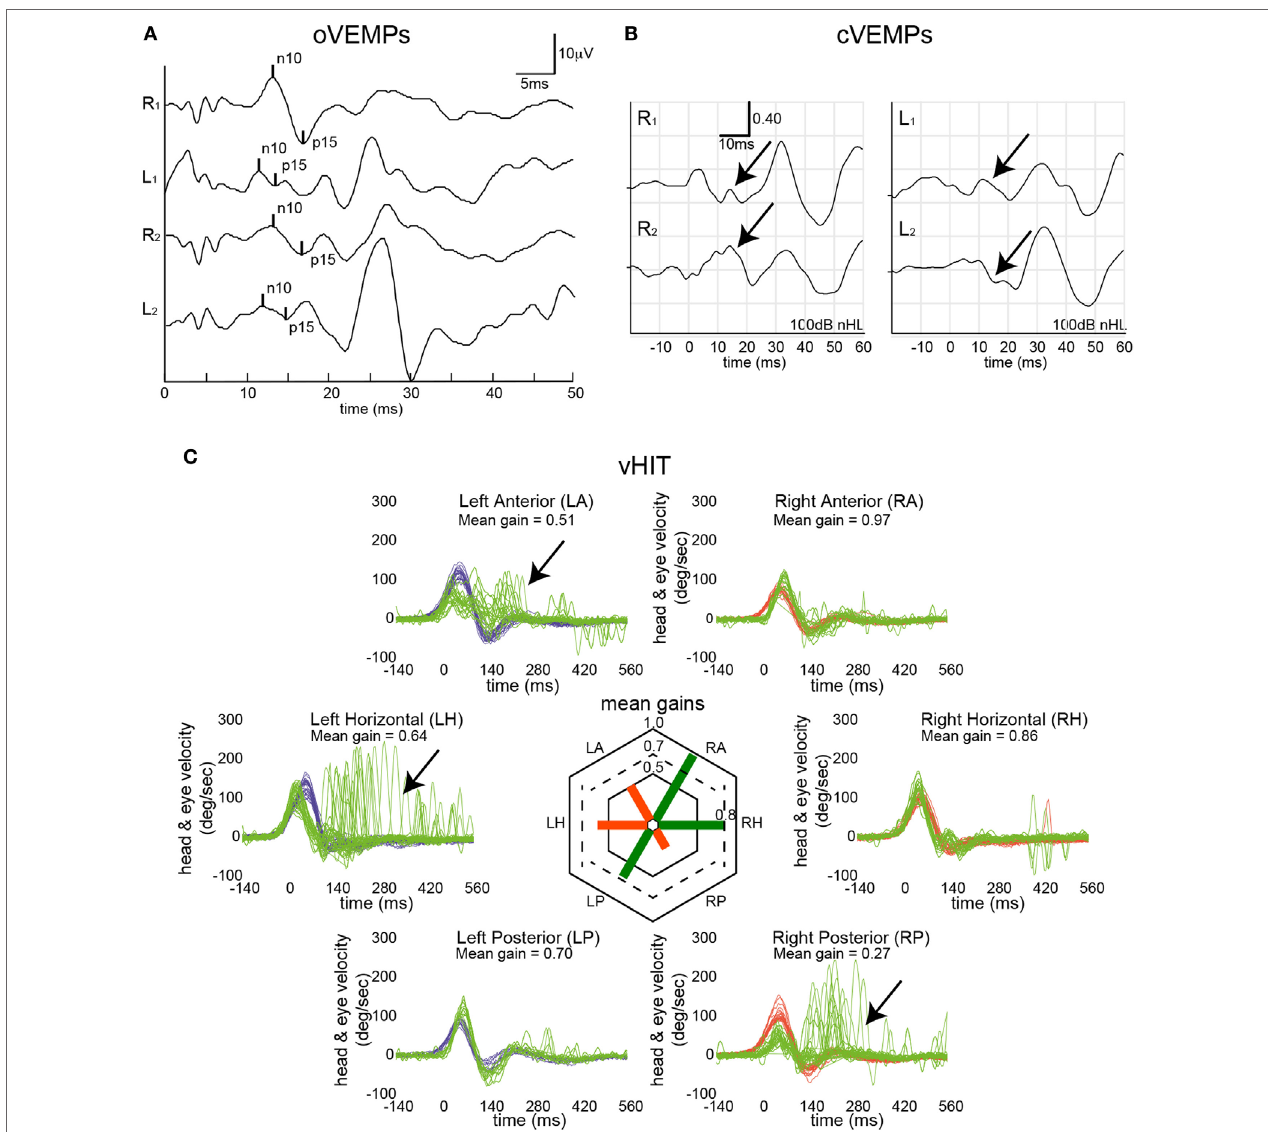
FigUre 1 | Vestibular mapping in a single patient with bilateral Menière’s disease. Otolith testing indicated left-sided utricular impairment [ocular vestibular-evoked myogenic potentials (oVEMPs) (a) ] based on two repetitions with an average asymmetry ratio of 67% (cutoff ≤ 30%) and a reduced peak-to-peak amplitude (3.64 µV, 5th percentile = 5.8 μ V), while n10 and p15 latencies were within normal range. Bone-conducted cervical vestibular-evoked myogenic potentials (cVEMPs) (B) were bilaterally absent (as indicated by the black arrows). In panel (c) , eye velocity traces (in green) and head velocity traces (in blue for head turns to the left and in red for head turns to the right) are plotted against time for each semicircular canal (20 trials per canal recorded). Note that eye velocity traces were inverted for better visualization and comparison with the head velocity traces. Catch-up saccades identified by OtosuiteV 3.0 are presented in dark red. vHIT demonstrated loss of function (as indicated by the black arrows) in the left horizontal and left anterior canal and the right posterior